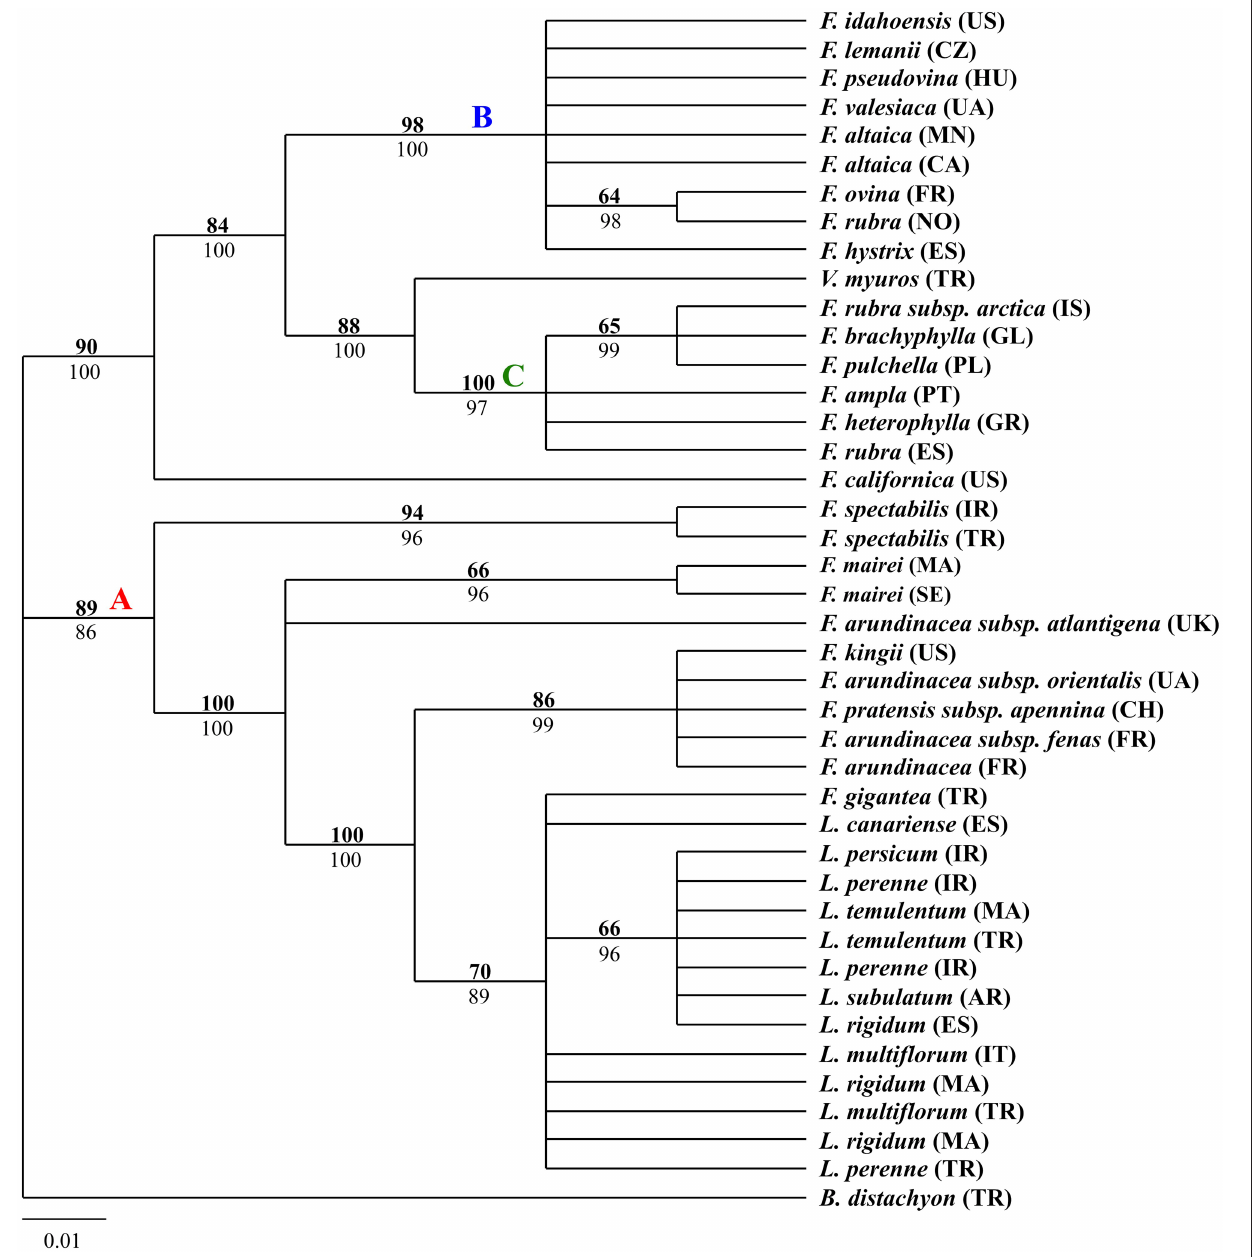
Frontiers in Ecology and Evolution |